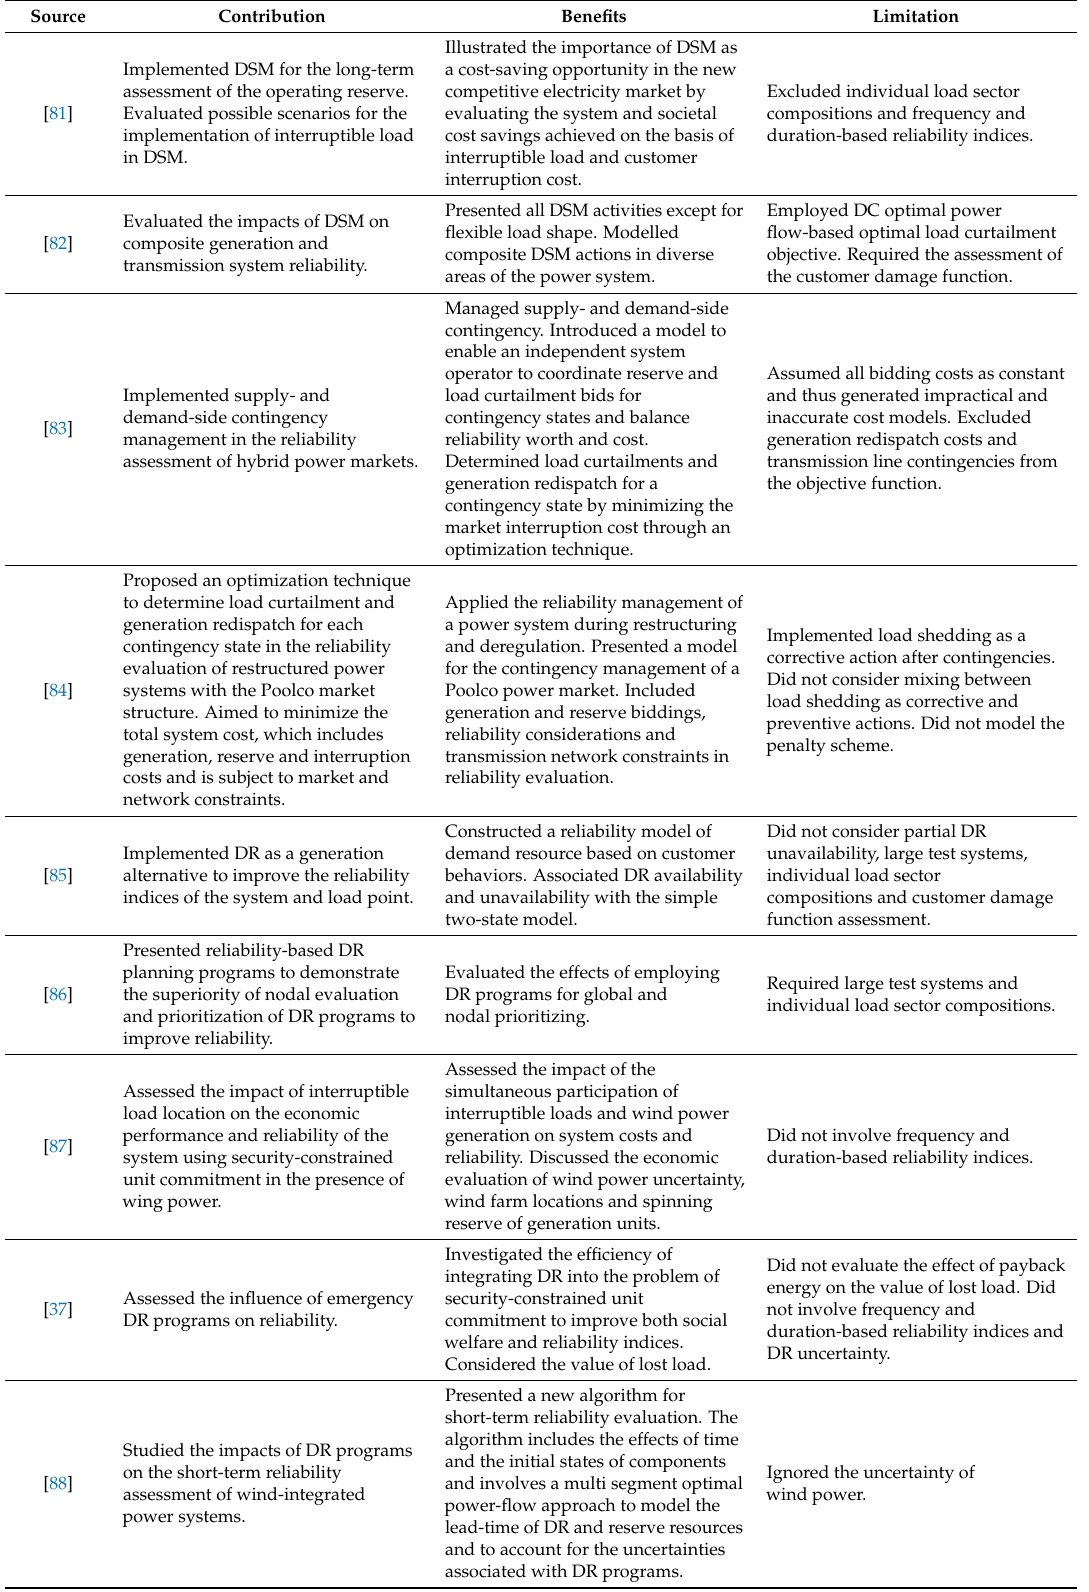
Table 2. Comparison of notable works on the impacts of DSM on